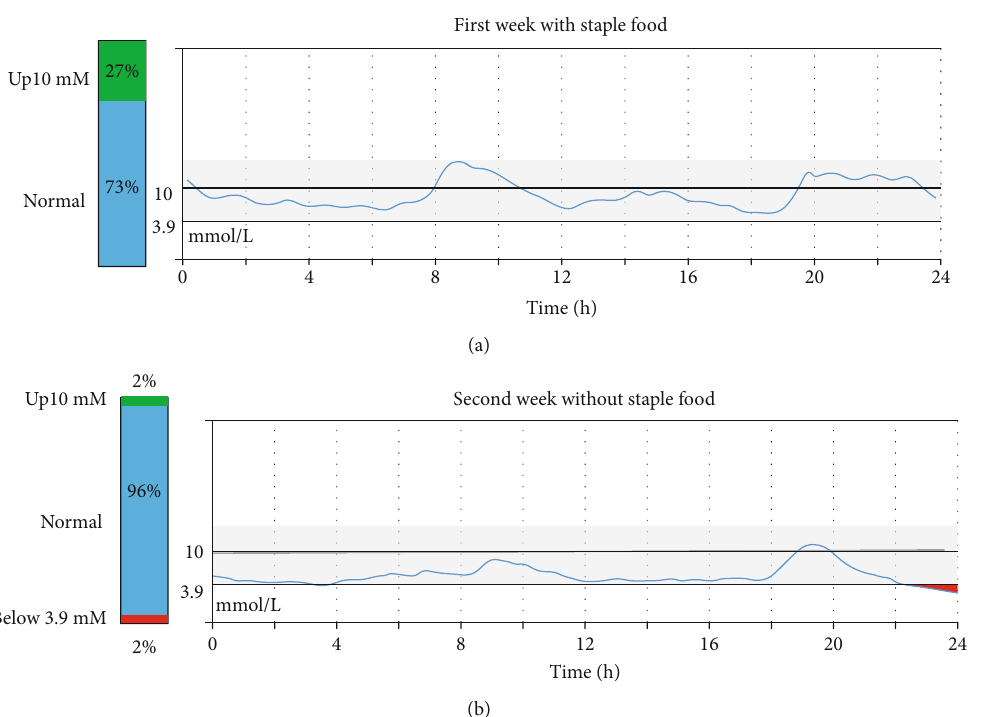
Figure 4: Representative data of the scanning dynamic glucose monitoring report for the proband with and without staple food intake. The proband wore the Freestyle Libre H (Abbott Diabetes Care Ltd.) for the dynamic monitoring of the blood glucose levels for 14 days. The proband needed to maintain normal staple food intake during the fi rst week, while no staple food intake was allowed during the second week; the amount of calories for each meal was recorded through the “ mint app ” (China) on the phone. No exercise adjustments were performed in these two weeks. After 14 days, the data were analyzed to obtain the following results: (a) representative data of the scanning dynamic glucose monitoring report for the proband with staple food intake. The proband was shown to have a glucose level above 10mmol/L for approximately 27% of the day; (b) representative data of the scanning dynamic glucose monitoring report for the proband without staple food intake. The proband was shown to have glucose levels above 10mmol/L for only about 2% of the